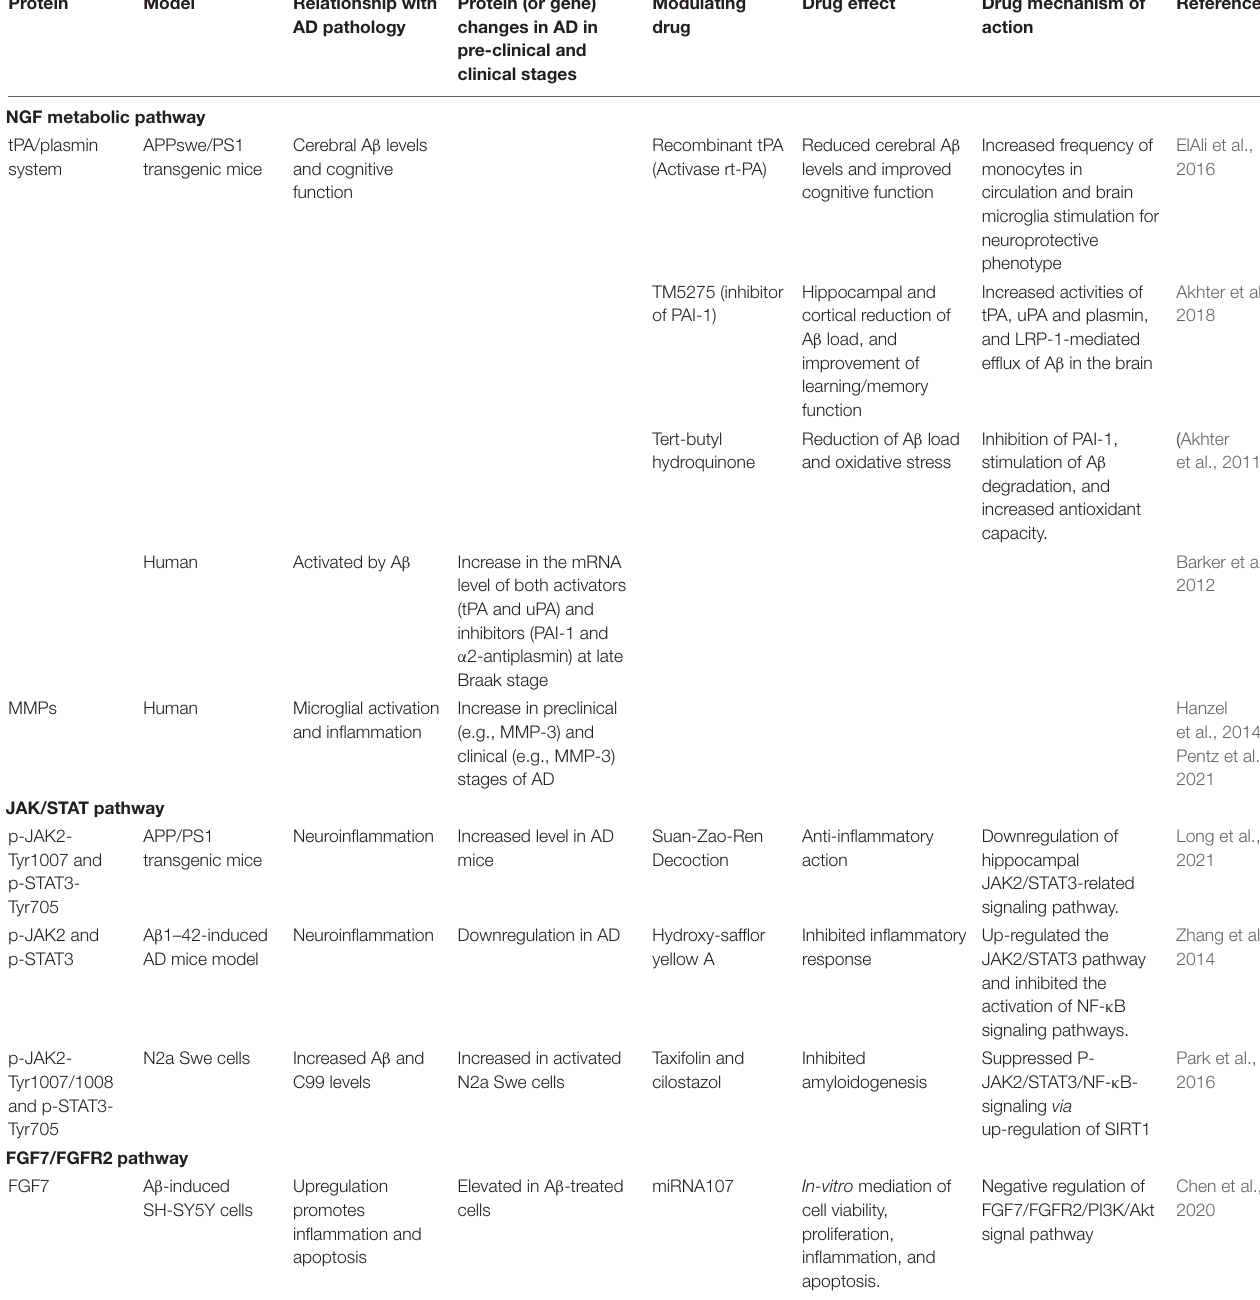
TABLE 2 | Important proteins involved in the AD